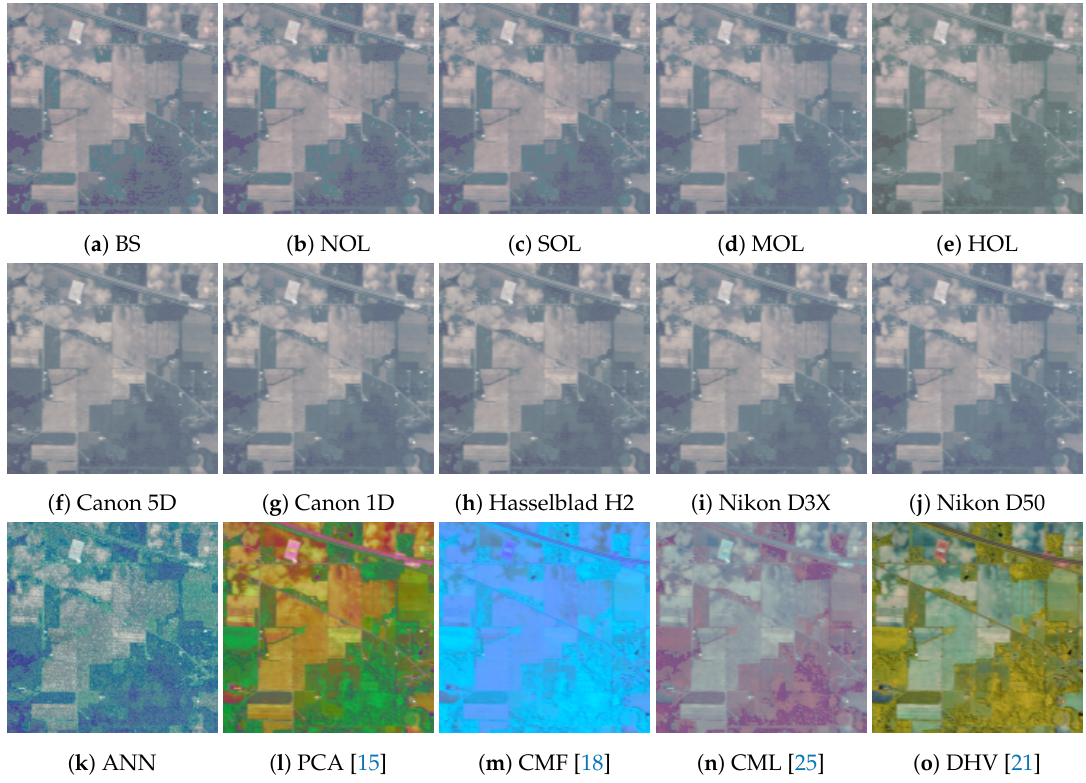
Figure 11. Experimental results on the Indian Pines image. ( a ) BS. ( b ) NOL. ( c ) SOL. ( d ) MOL. ( e ) HOL. ( f ) Canon 5D. ( g ) Canon 1D. ( h ) Hasselblad H2. ( i ) Nikon D3X. ( j ) Nikon D50. ( k ) ANN. ( l ) PCA [15]. ( m ) CMF [18]. ( n ) CML [25]. ( o ) DHV